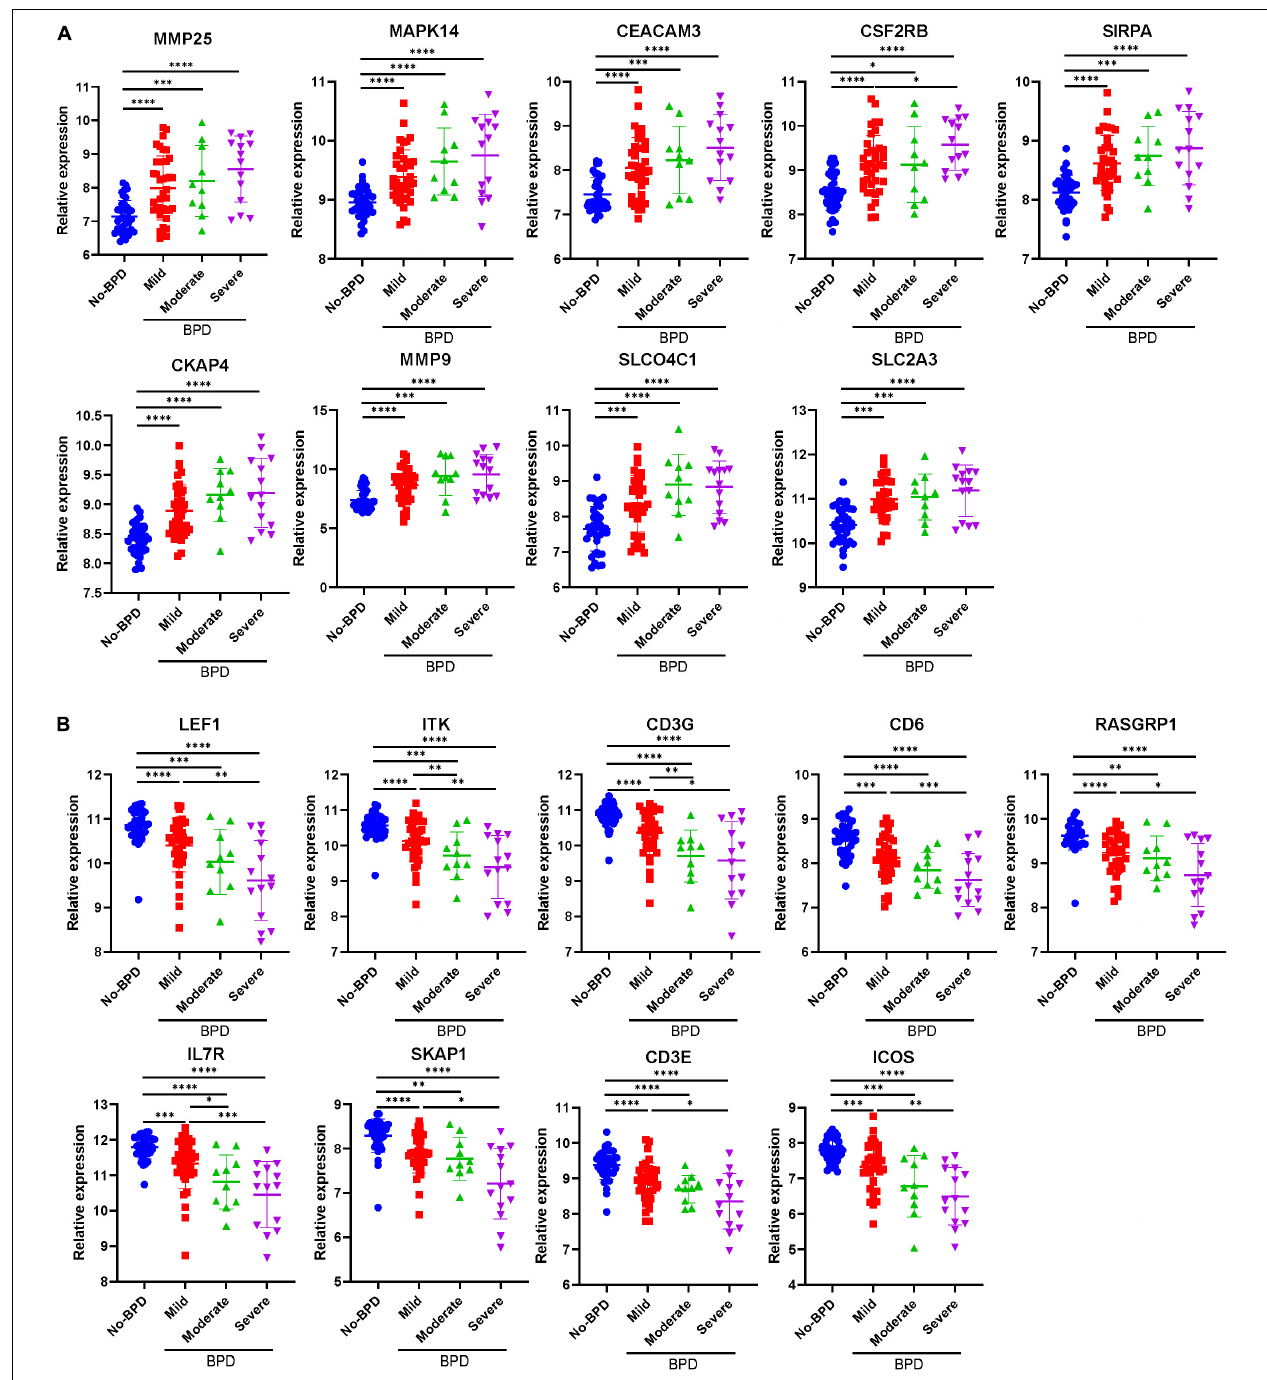
FIGURE 5 | Severity plot of the real hub genes. (A) Severity plot of the identified hub genes in the yellow module. (B) Severity plot of the identified hub genes in the red module. * P < 0.05, ** P < 0.01, *** P < 0.001, and **** P <